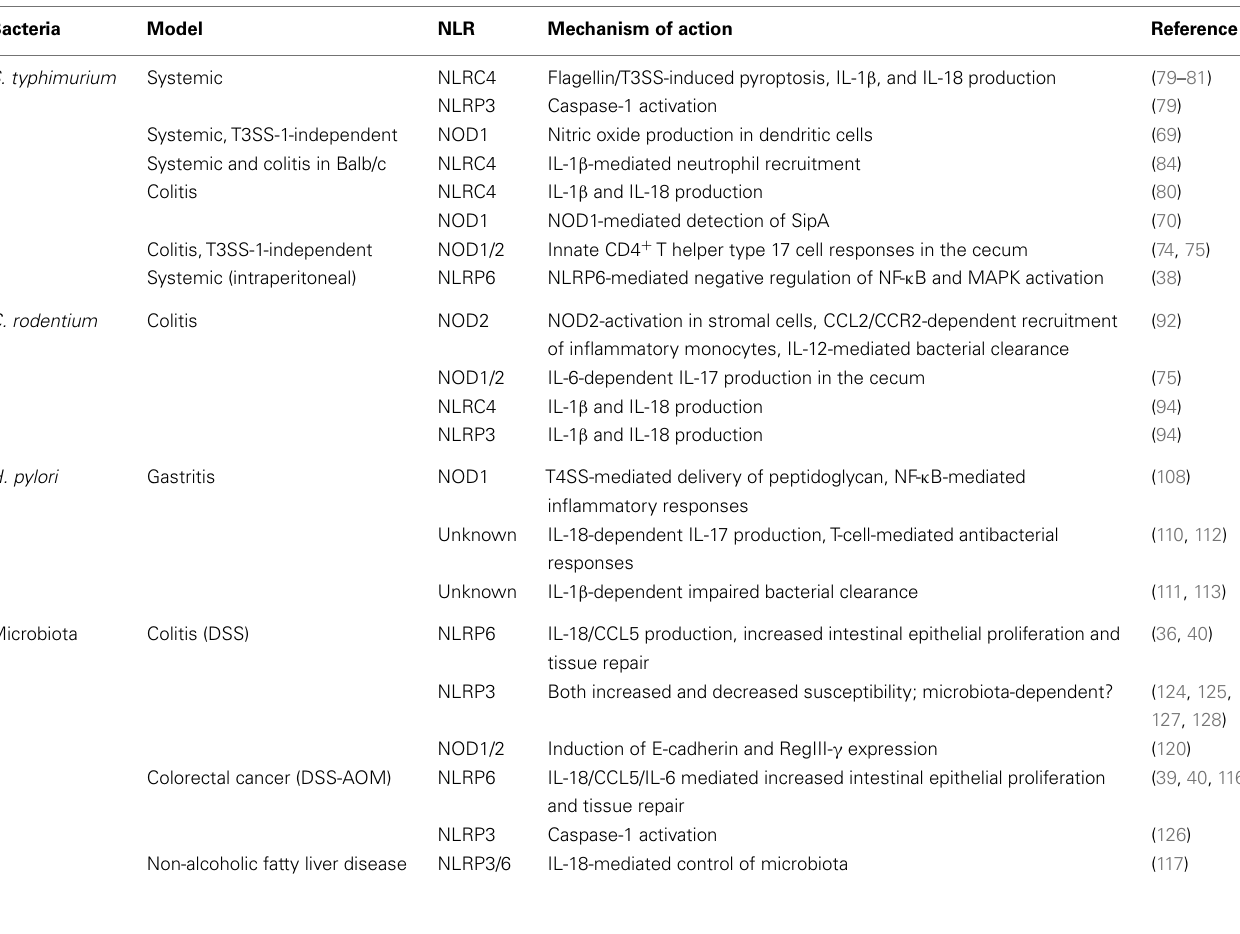
Table 1 | Role of NLRs in intestinal bacterial infections